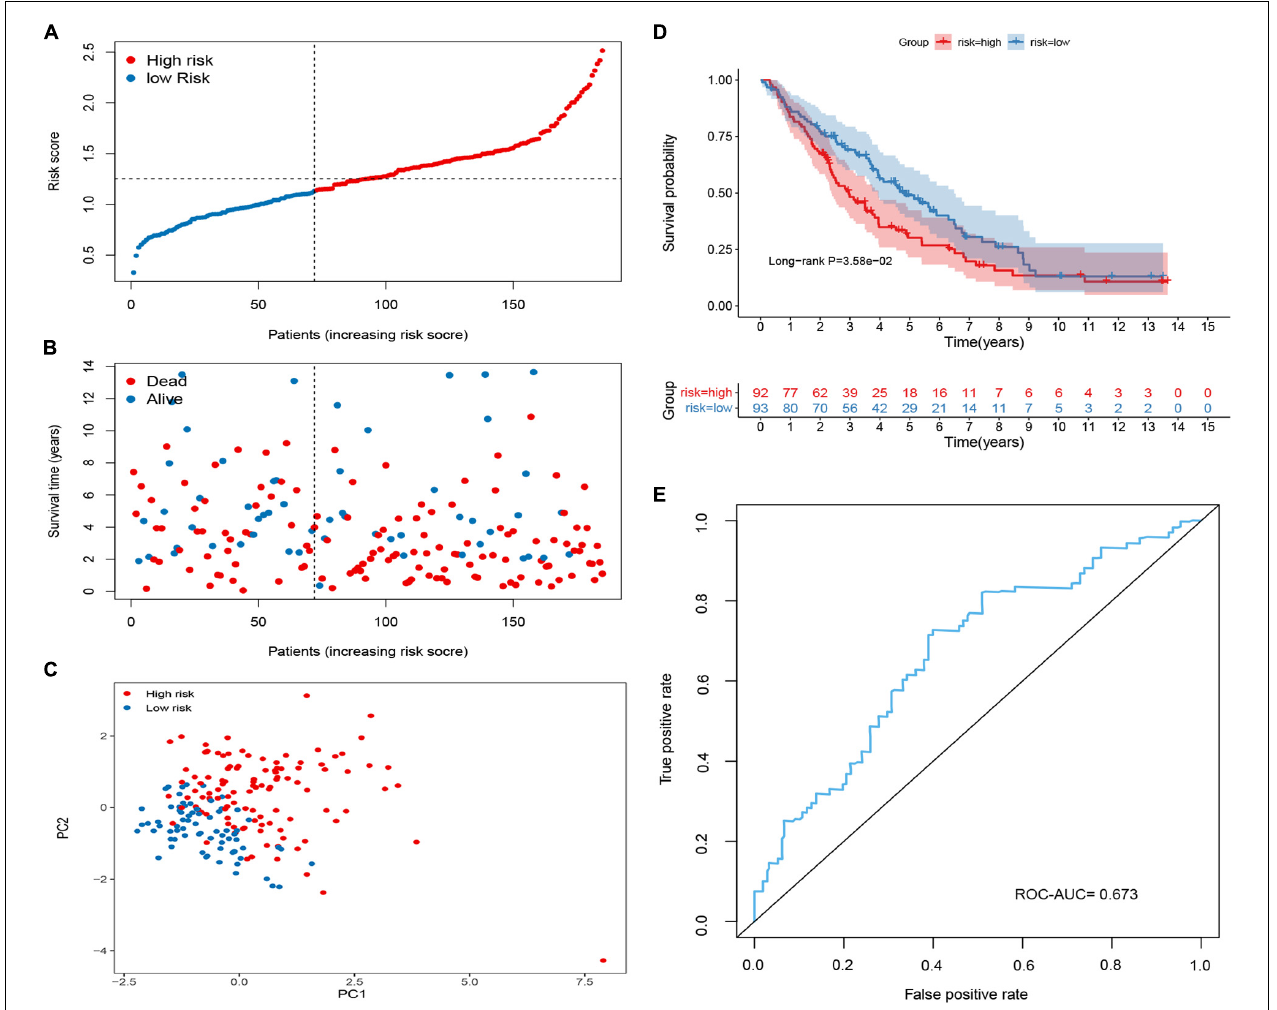
FIGURE 5 | Validation of the methylated related gene signature in the GSE26712 cohort. (A) Dot plot of risk score. Y axis represents risk score. Red and blue color dots represent, respectively, high and low risk score samples. (B) Dot plot of survival. Y axis represents survival times (years). Red and blue color dots represent, respectively, dead and living OC samples. (C) PCA plot of the GSE26712 cohort. (D) KM estimate of the OS in the GSE26712 cohort. (E) The time-dependent ROC curves in the GSE26712